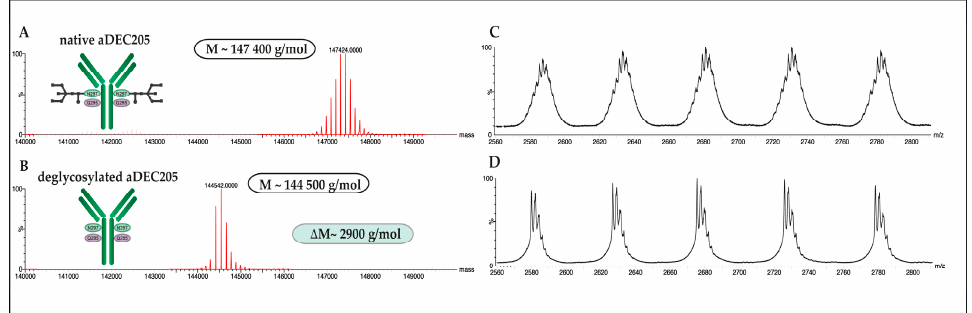
Figure 2. Mass spectra (deconvoluted): ( A ) Native aDEC205. ( B ) Deglycosylated aDEC205. Mass spectra ( m / z ) ( C ) Native aDEC205. ( D ) Deglycosylated aDEC205.